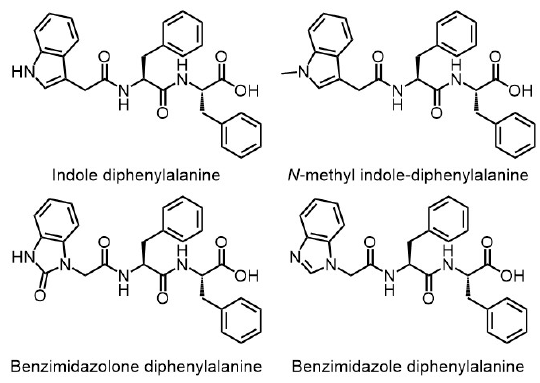
Figure 7. Chemical structure of FF-derived hydrogelators.